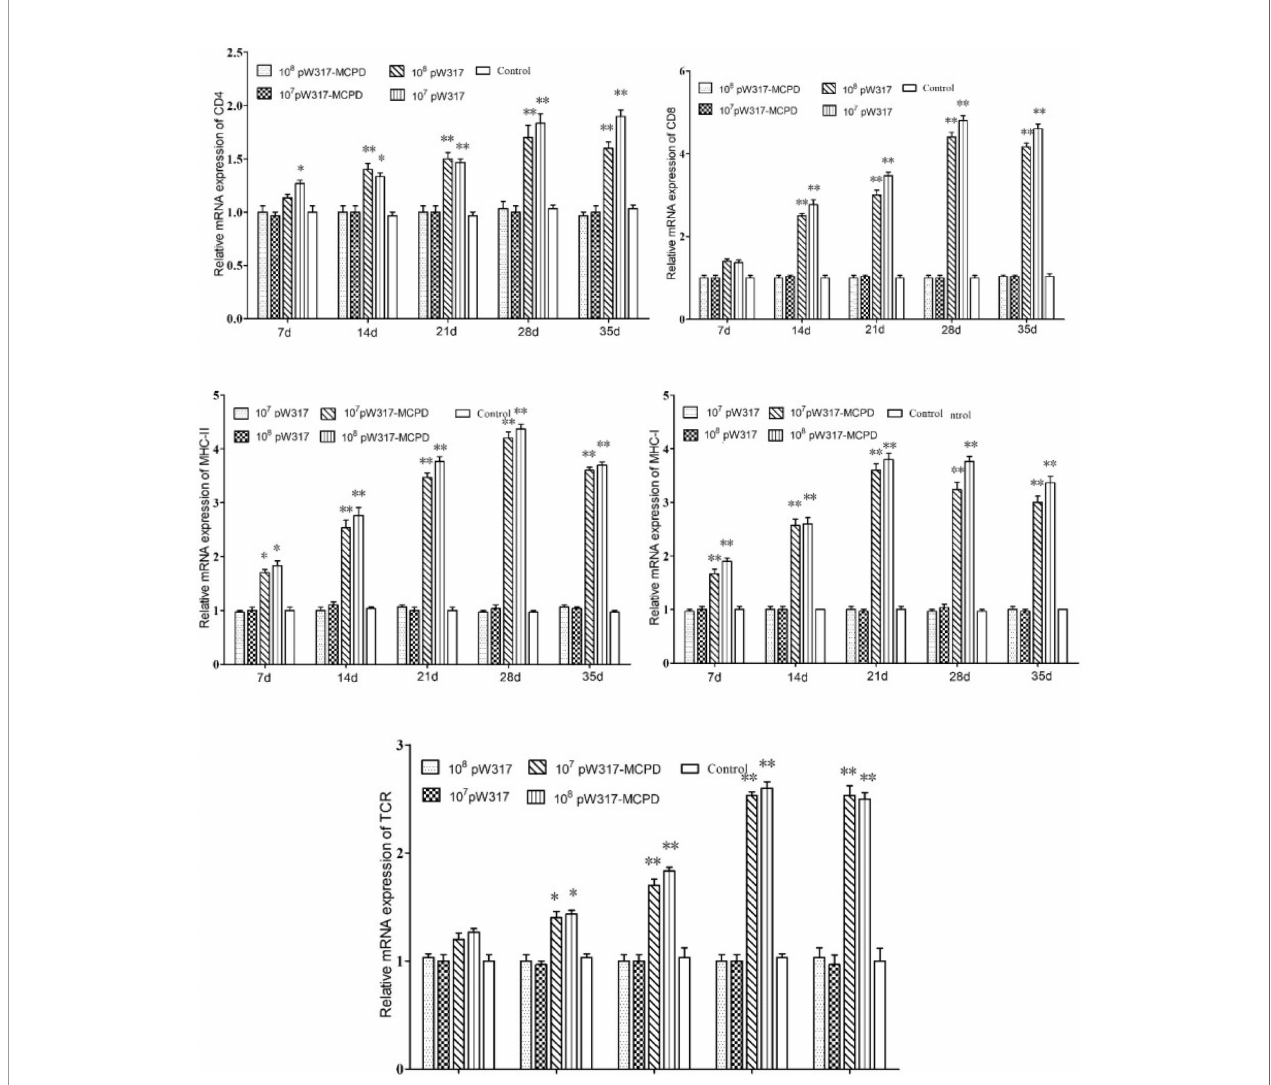
FIGURE 6 | The expression level of antigen presentation-related gene in head kidney after immunization. 10 7 pW317: 10 7 CFU/g GS115-pW317; 10 8 pW317: 10 8 CFU/g GS115-pW317; 10 7 pW317-MCPD: 10 7 CFU/g GS115-pW317-MCPD; 10 8 pW317-MCPD: 10 8 CFU/g GS115-pW317-MCPD. **P < 0.01; *P <